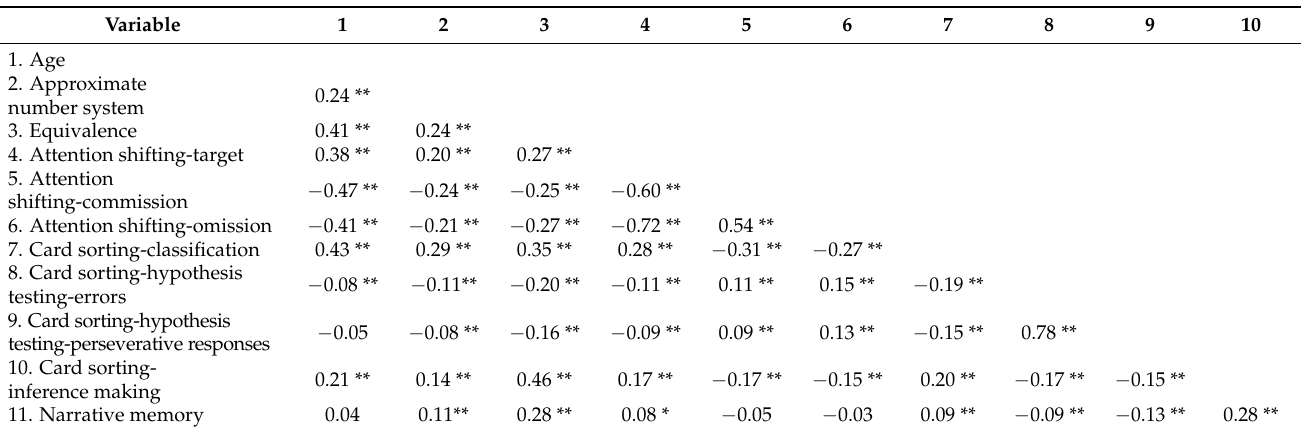
Table 4. Pearson correlation coefficients between age and subtest case examples.